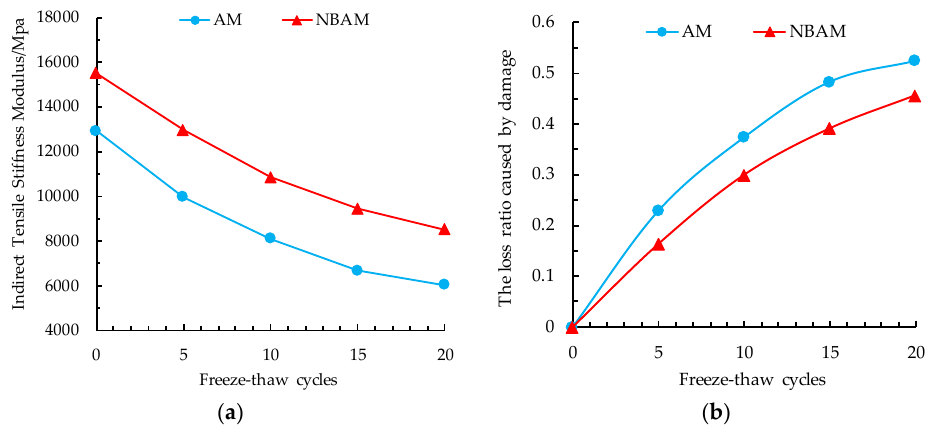
Figure 9. Relationship between indirect tensile stiffness modulus and freeze‒thaw cycles: ( a ) indirect tensile stiffness modulus; ( b ) loss ratio of stiffness modulus caused by damage.